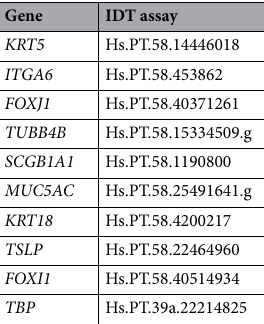
Table 1. Accession number of assays used to characterize apical-out airway